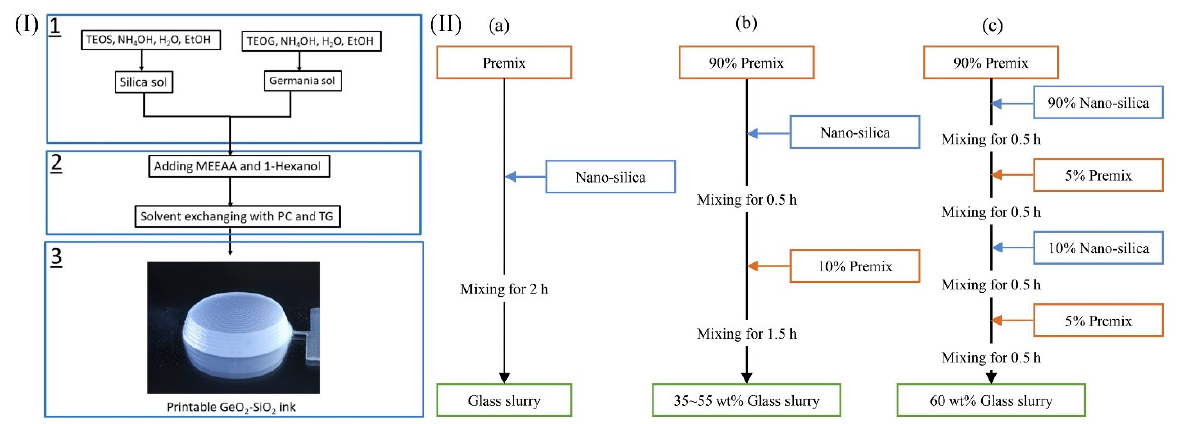
Figure 7. Viscosity reduction methods for “liquid glass”. ( I ) Reprinted with permission from ref. [15]. ( II ) Reprinted with permission from ref. [36].